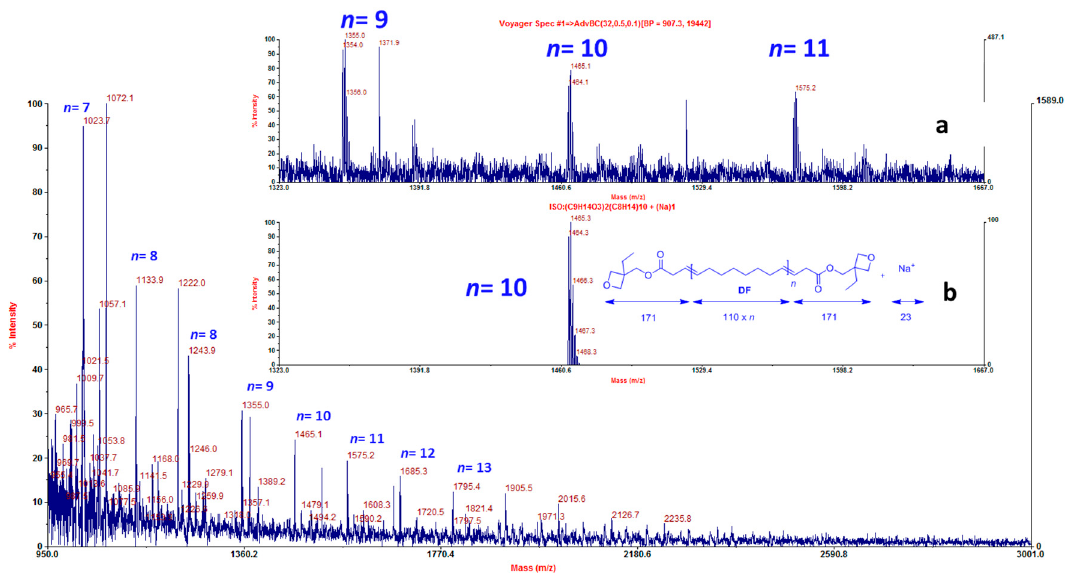
Figure 2. MALDI-ToF mass spectrum (DCTB matrix, Na ionizing salt) of an α , ω -dioxetane telechelic PCOE sample that was prepared by ROMP/CM of COE in the presence of G2 /CTA 3 (Table 1, entry 4); see top zoomed region and the corresponding bottom simulation for n = 10.